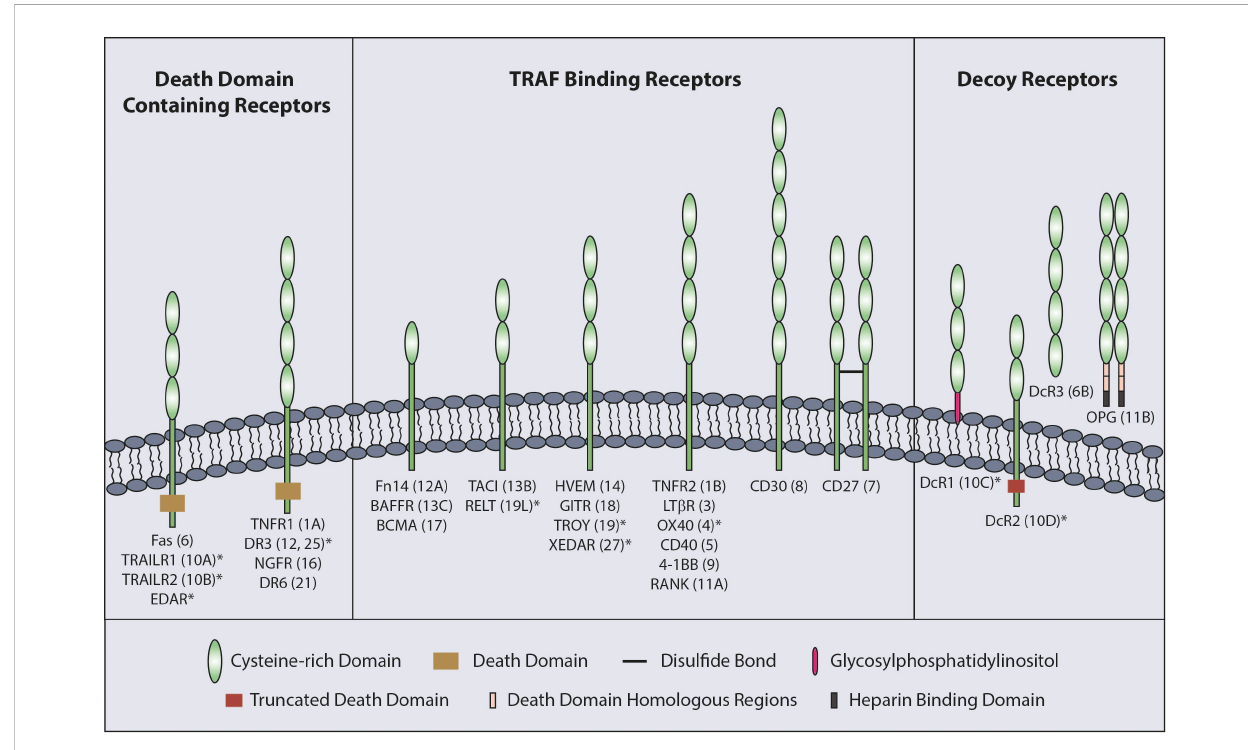
FIGURE 1 Classi fi cation of TNFRSF. The TNFRSF can be classi fi ed into three sub-families. All twenty-nine members of the family, grouped into three sub- families, are indicated with the number of CRDs on their extracellular region and TNFRSF number in brackets. CRD domains are de fi ned by Uniprot with the exception of RELT which was published as having two CRDs (4). * indicates the receptors with a truncated CRD